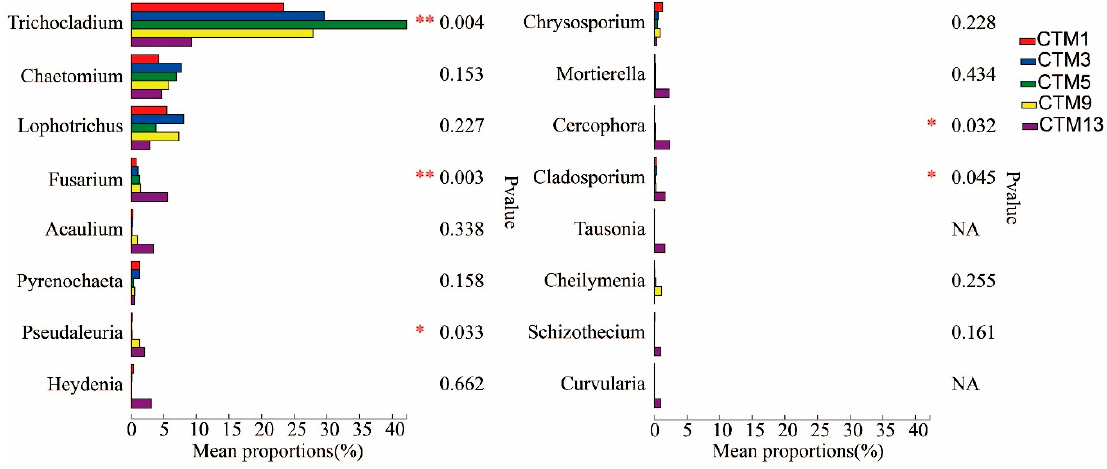
Figure 3. Difference analysis of soil fungal genera among different CTM cycles. Significances between different treatments were compared using One − way ANOVA, with the results indicated by red asterisks (** p < 0.01; * p < 0.05).